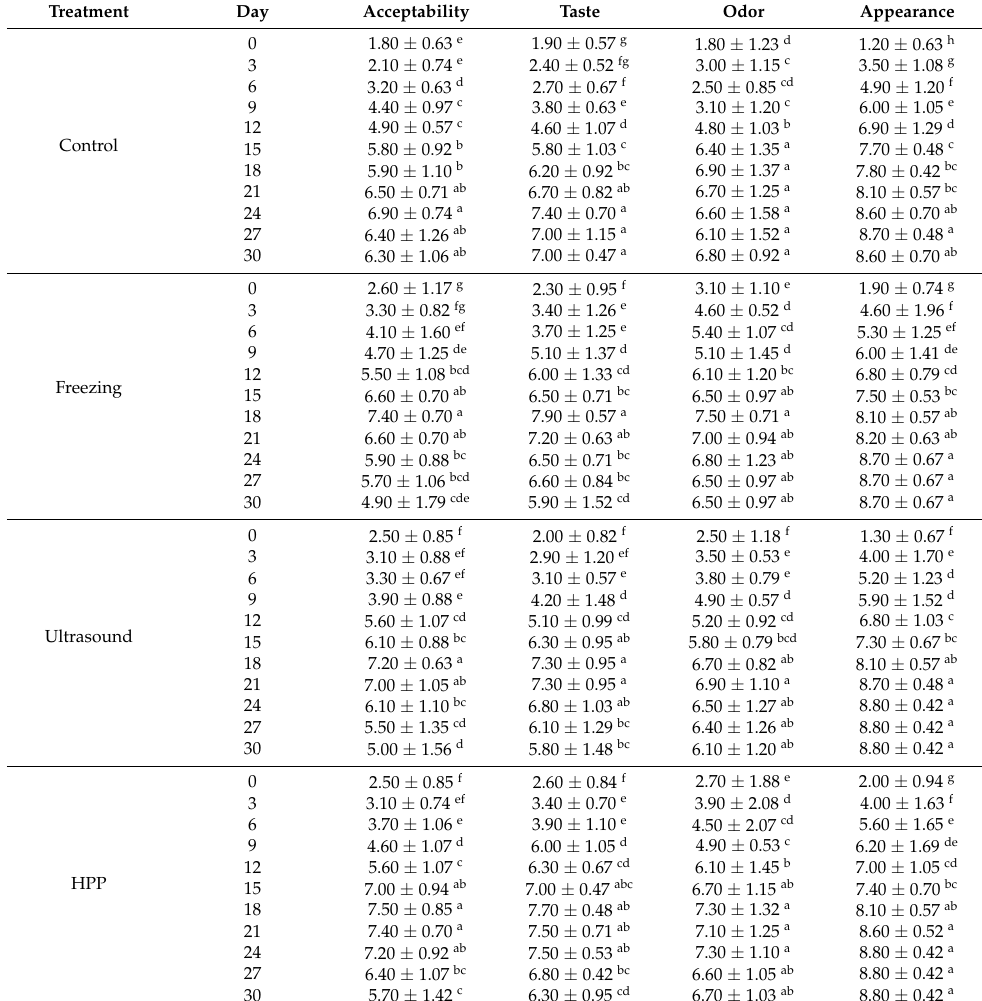
Values are means ± SD ( n = 3). In the same pretreatments, values with different superscripts within the same column are significantly different ( p < 0.05). The relationships between functional ingredients and sensory evaluation were ana- lyzed using Pearson’s correlation coefficient, as presented in Table